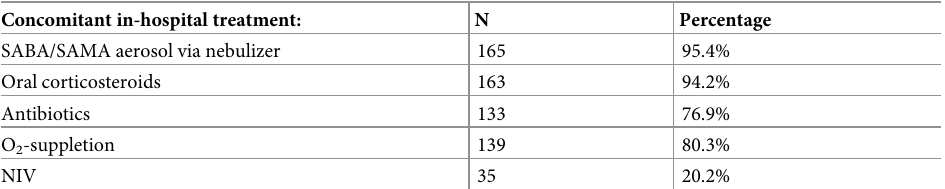
Table 2. Concomitant in-hospital treatment.